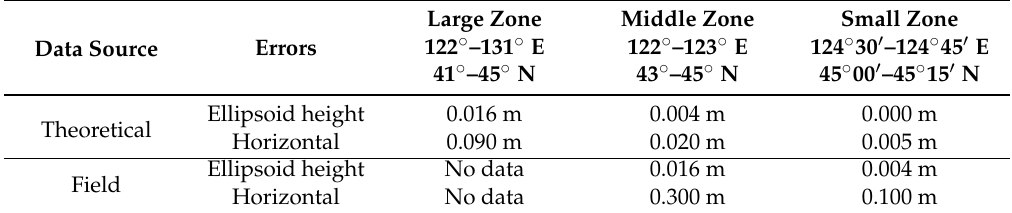
Table 2. The calculation errors of both theoretical and field data (CGCS2000 to